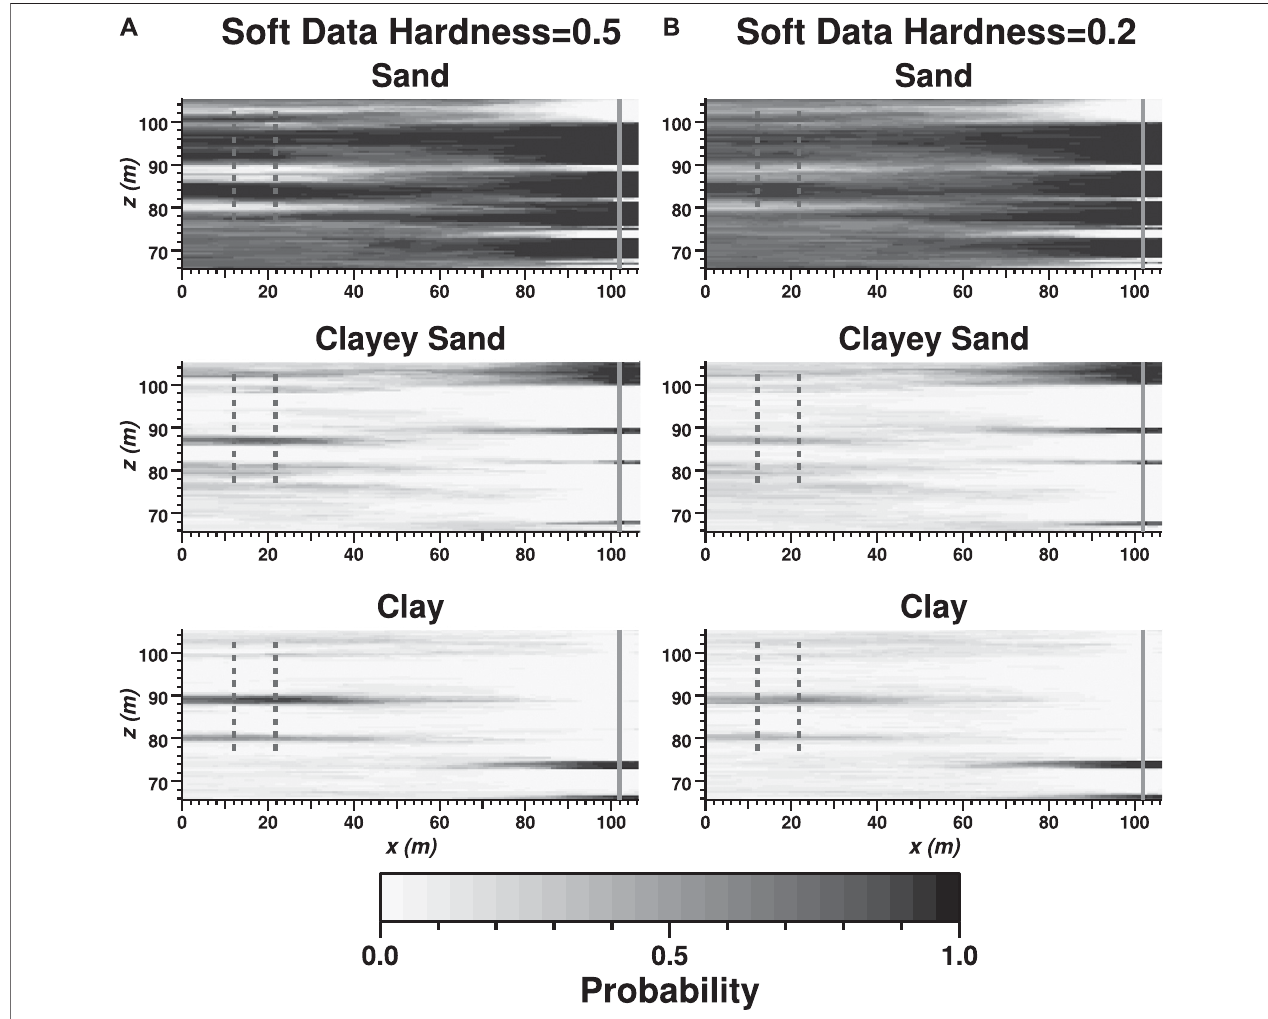
FIGURE 5 | Maps of probability of occurrence for sand, clayey sand, and clay lithofacies, based on mean indicator value of 100 realizations, for cases of hard and soft data with (A) soft data hardness (cid:2) 0.5, and (B) soft data hardness (cid:2) 0.2.